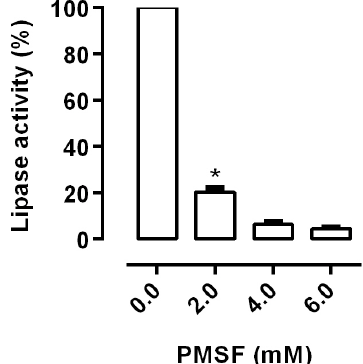
Figure 4. Effects of phenylmethane sulfonyl fluoride (PMSF) on the lipase activities of the posterior midgut homogenate (crude extract) of R. palmarum larvae. The incubations were performed with different PMSF concentrations. The error bars represent the SD for the three determinations (* p < 0.05).